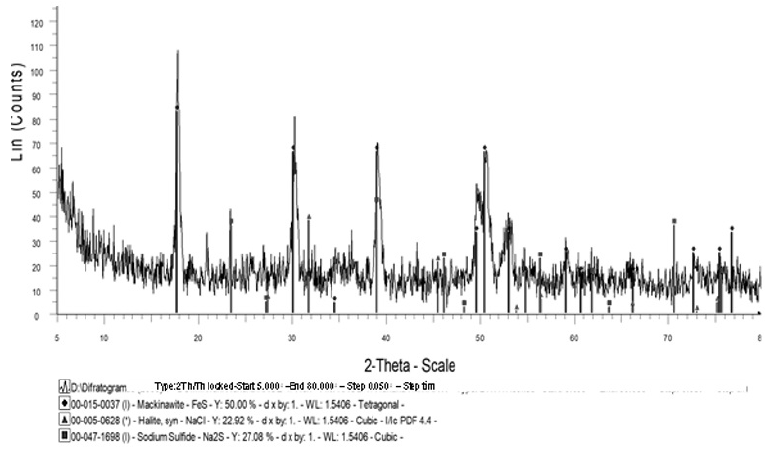
Figure 10. XRD spectrum of the corrosion product film of the welded joint that was tested in in solution 2 with pH=3.0